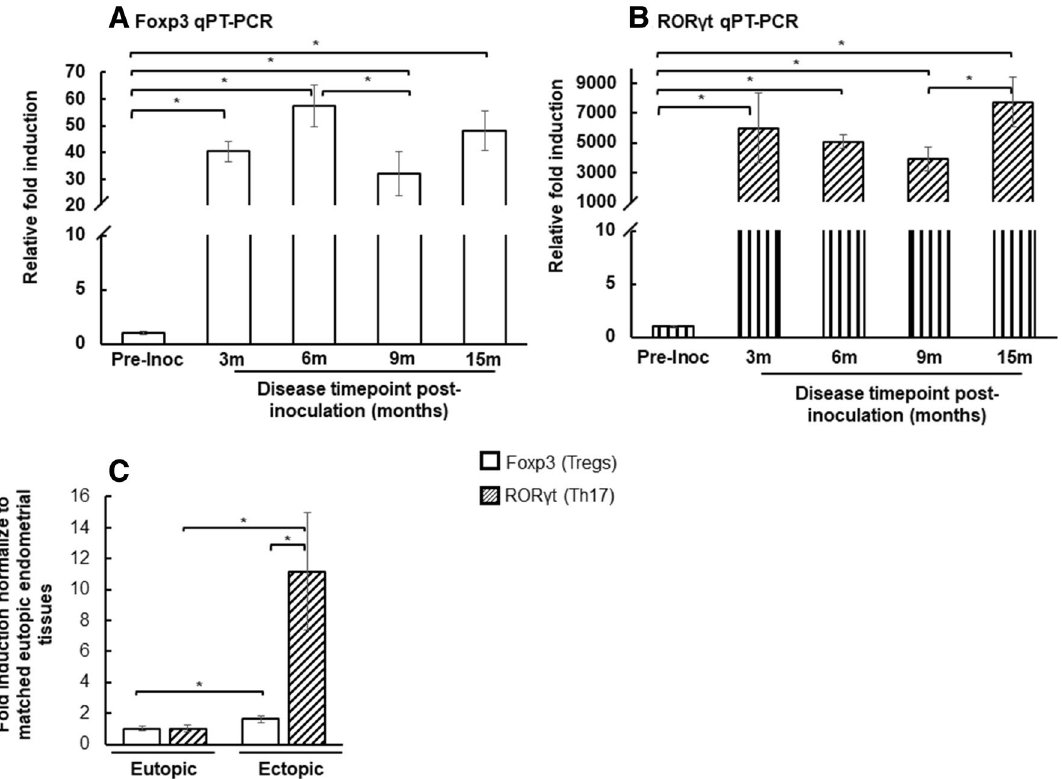
Figure 2. Foxp3 and RORγt quantitative RT–PCR of non-human primates eutopic and ectopic endometrial tissues. ( A ) Foxp3, and ( B ) RORγt transcript levels were measured in the eutopic endometrium tissues of 8 baboons at pre-inoculation: 3, 6, 9 and 15 months. The relative fold induction of Foxp3 and RORγt genes was normalized to H3.3 endogenous gene for all experimental conditions. *Indicates significant difference between compared groups. ( C ) Fold induction for each eutopic to matched ectopic endometrial tissues at 15 months collection. The ectopic endometrial tissues was normalized to matched eutopic endometrial tissues for all 8 animals. Mann–Whitney U -test, p- value <